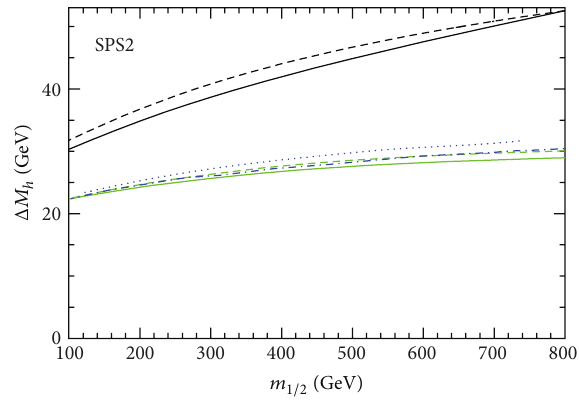
Figure 12: Comparison of complete and approximate one- and two- loop corrections to the Higgs boson mass for SPS2 scenario. The solid (full result) and dashed lines ( 𝑚 4 𝑡 approximation) represent the results in the on-shell scheme where the black and gray curves correspond to the one- and two-loop results, respectively. For comparison, the two-loop DR results are shown as dash-dotted (full result) and dotted ( 𝑚 4 𝑡 approximation)